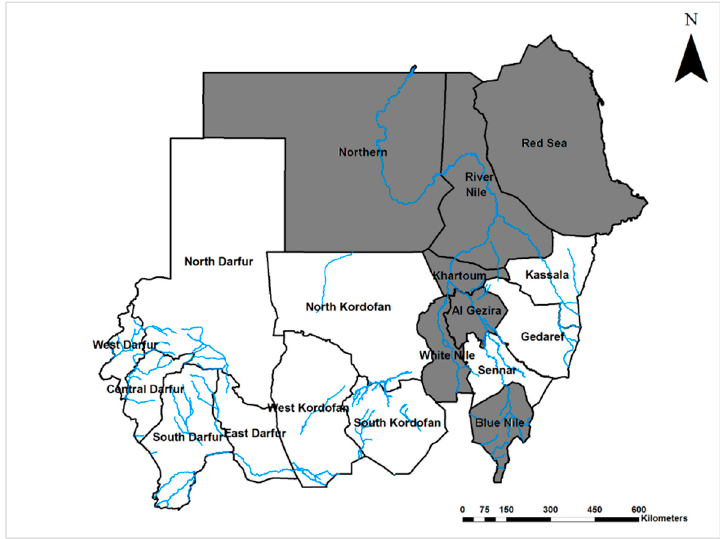
Figure 3. Map of Sudan showing the prevalence of West Nile virus infections (Green).